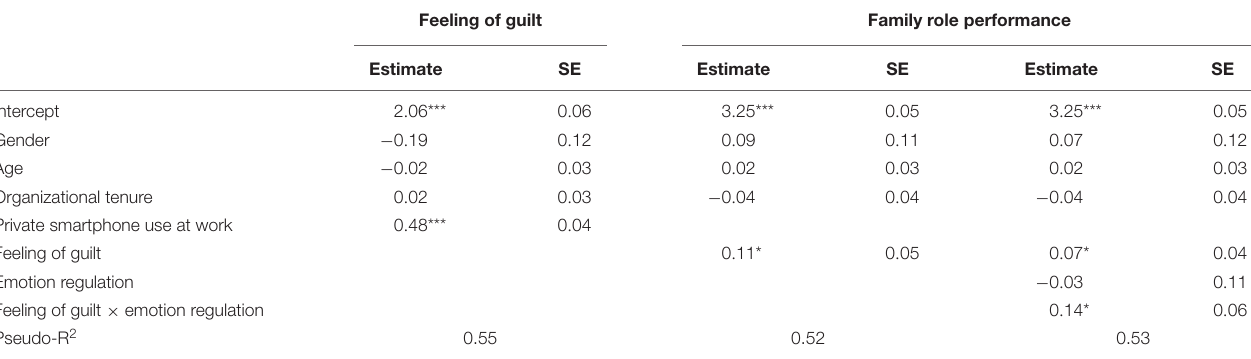
TABLE 2 | Unstandardized coefficients of the multilevel model.